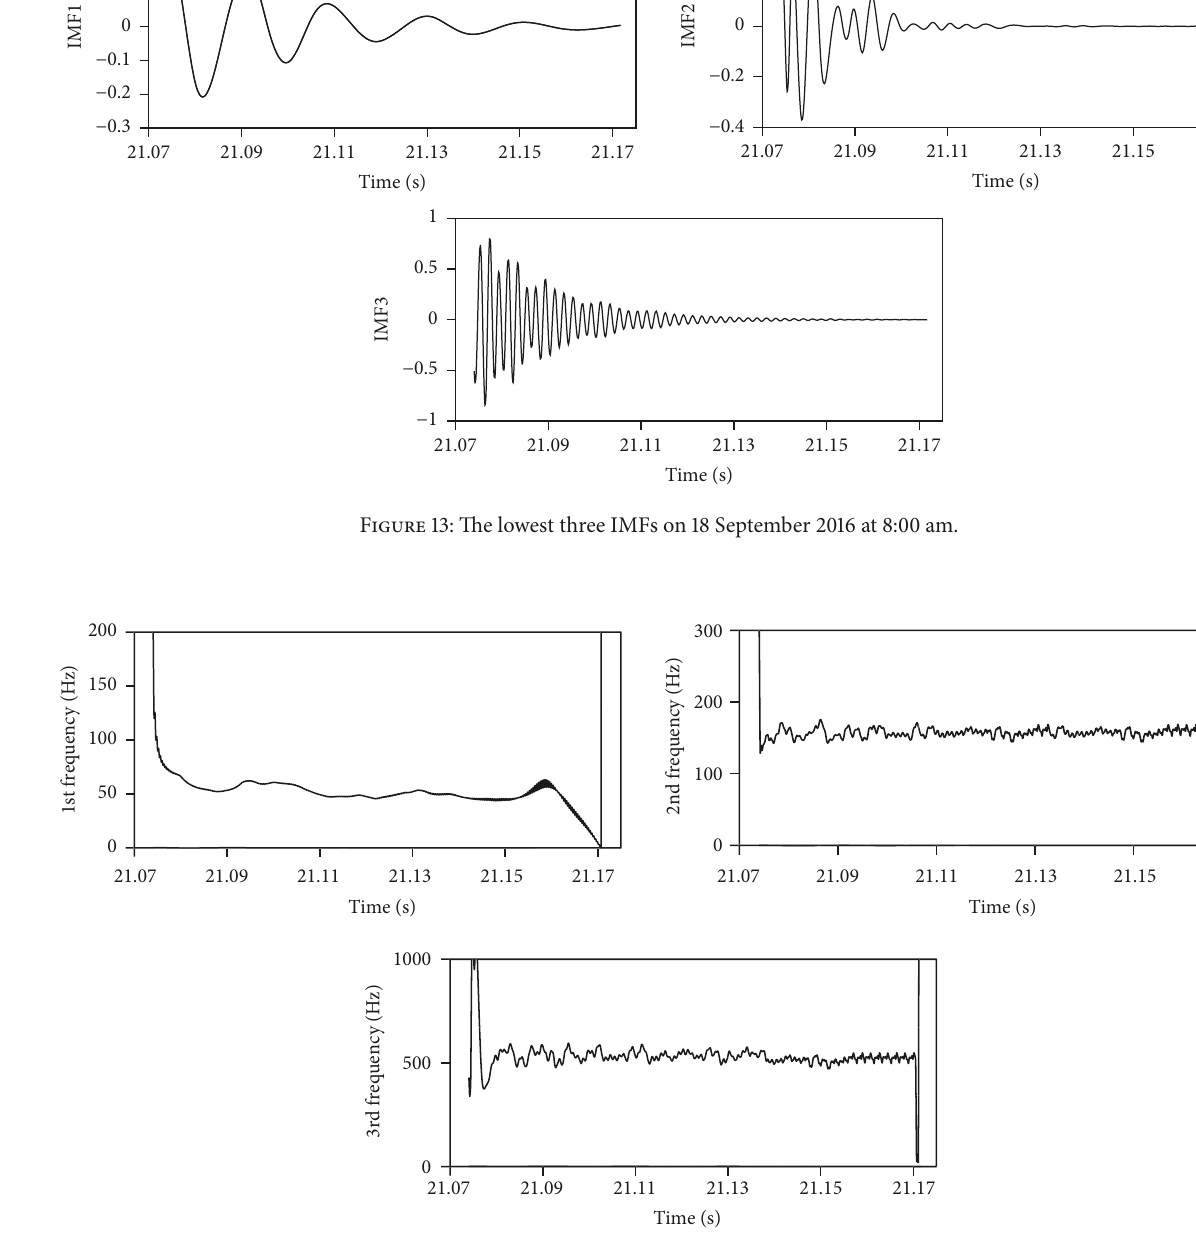
Figure 14: The lowest three frequencies on 18 September 2016 at 8:00